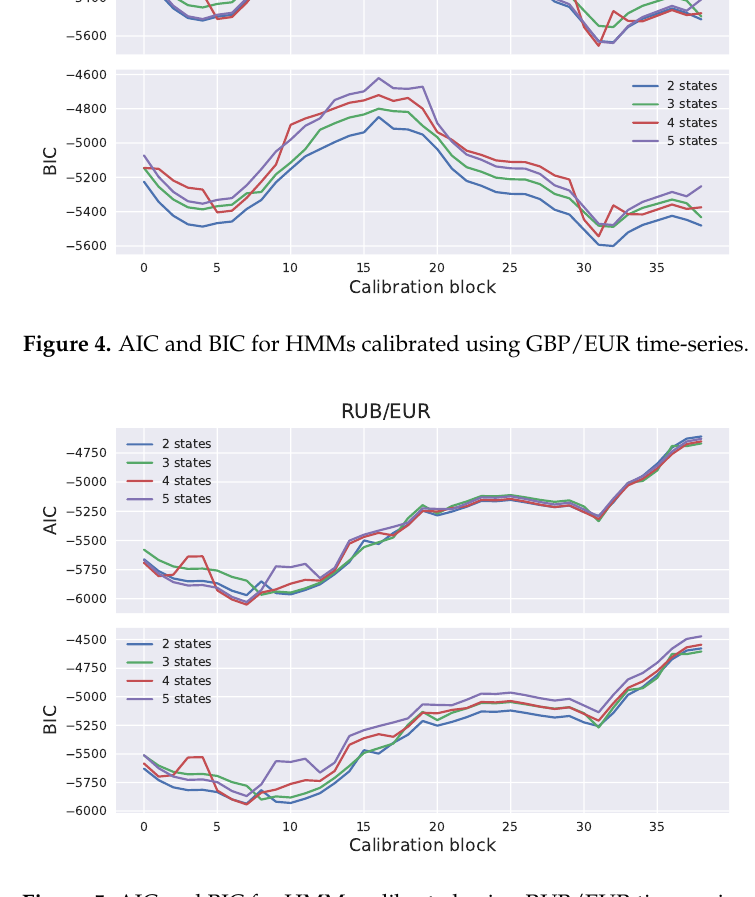
Figure 5. AIC and BIC for HMMs calibrated using RUB/EUR